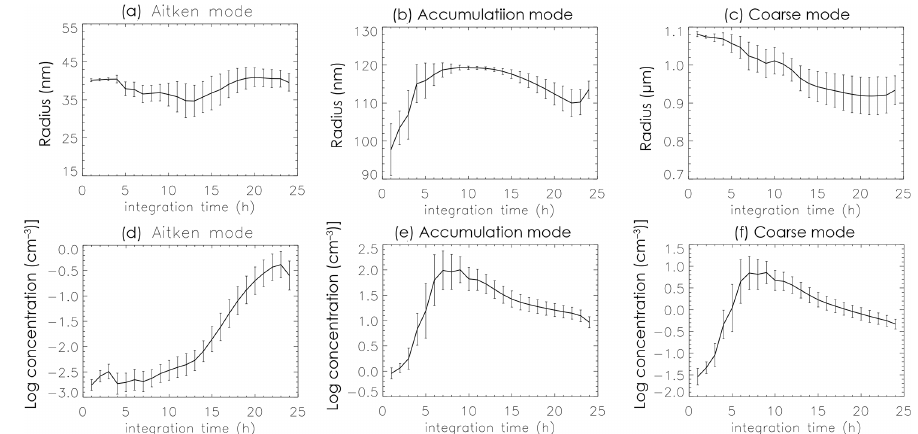
Figure 7. Time series of the mean ± 1 standard deviation of the geometric radius (a, b, c) and the logarithm of the concentration (d, e, f) of the surface aerosols from the Aitken (a, d) , accumulation (b, e) and coarse (c, f) soluble modes. The initial time of the simulation is 09:00UTC on 24 May